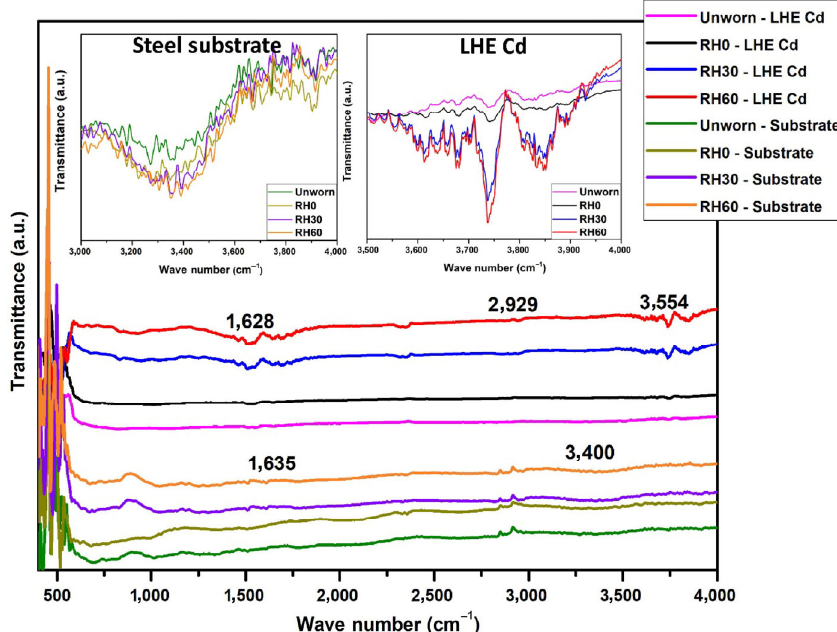
Fig. 18 FTIR spectra of wear